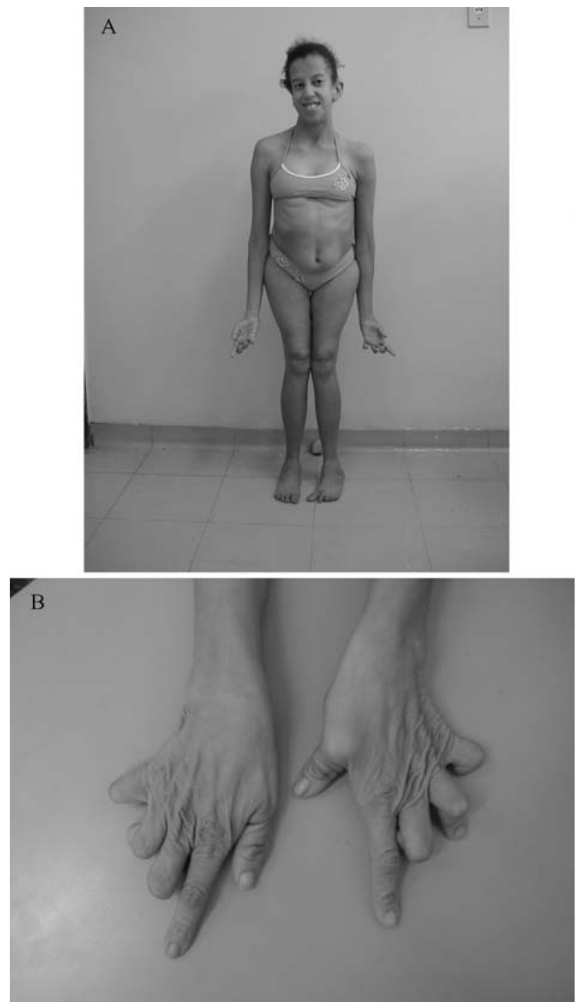
Figure 4 - Patient 2 at 10 years of age. Note the prominent abdomen, genu valgum, lumbar lordosis and prognathism (A) as well as the aged appear - ance of the dorsum of the hands with abnormal positioning of the fin- gers (B).